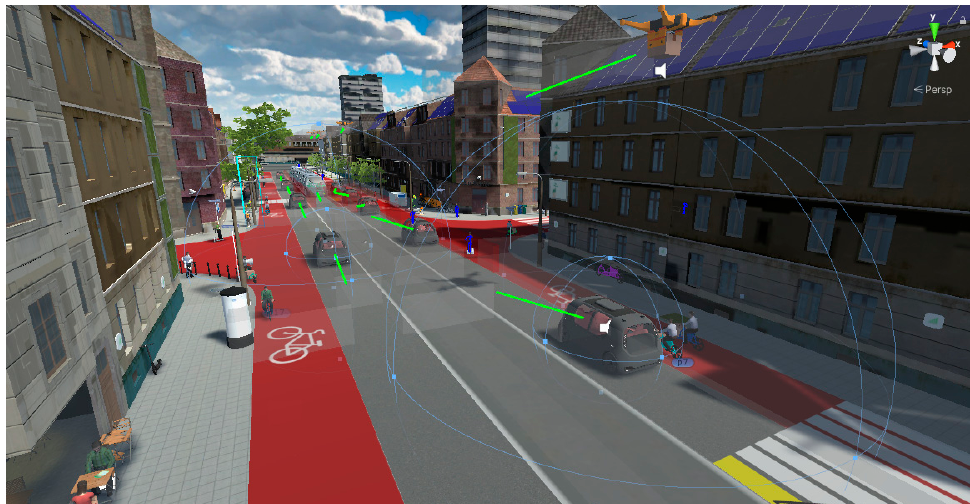
Figure 2. Urban soundscape in the game engine Unity (Source: Marco Weißmann and Dennis Edler, Geomatics Group, Ruhr-University Bochum). The sphere around the vehicle indicates the range of the spatial sound intensity in 3D. The level of loudness decreases with a greater distance from the source (vehicle).